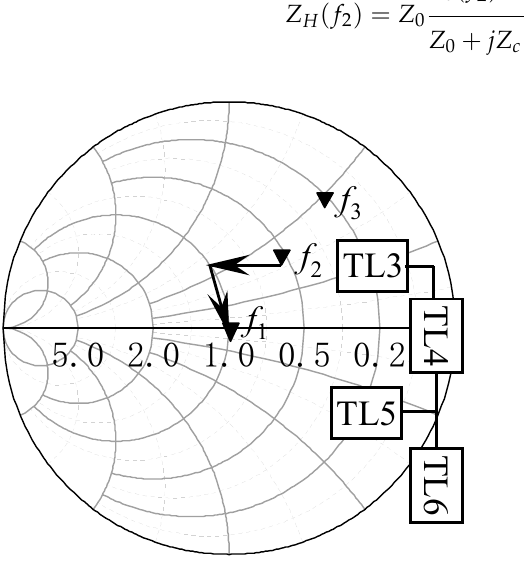
Figure 1, the susceptance of the second frequency band 𝑓 (cid:2870) is canceled as needed 𝑌 (cid:3009) (𝑓 (cid:2870) ) , The desired load impedance 𝑍 (cid:3004) (𝑓 (cid:2870) ) can be obtained by Equation (5):